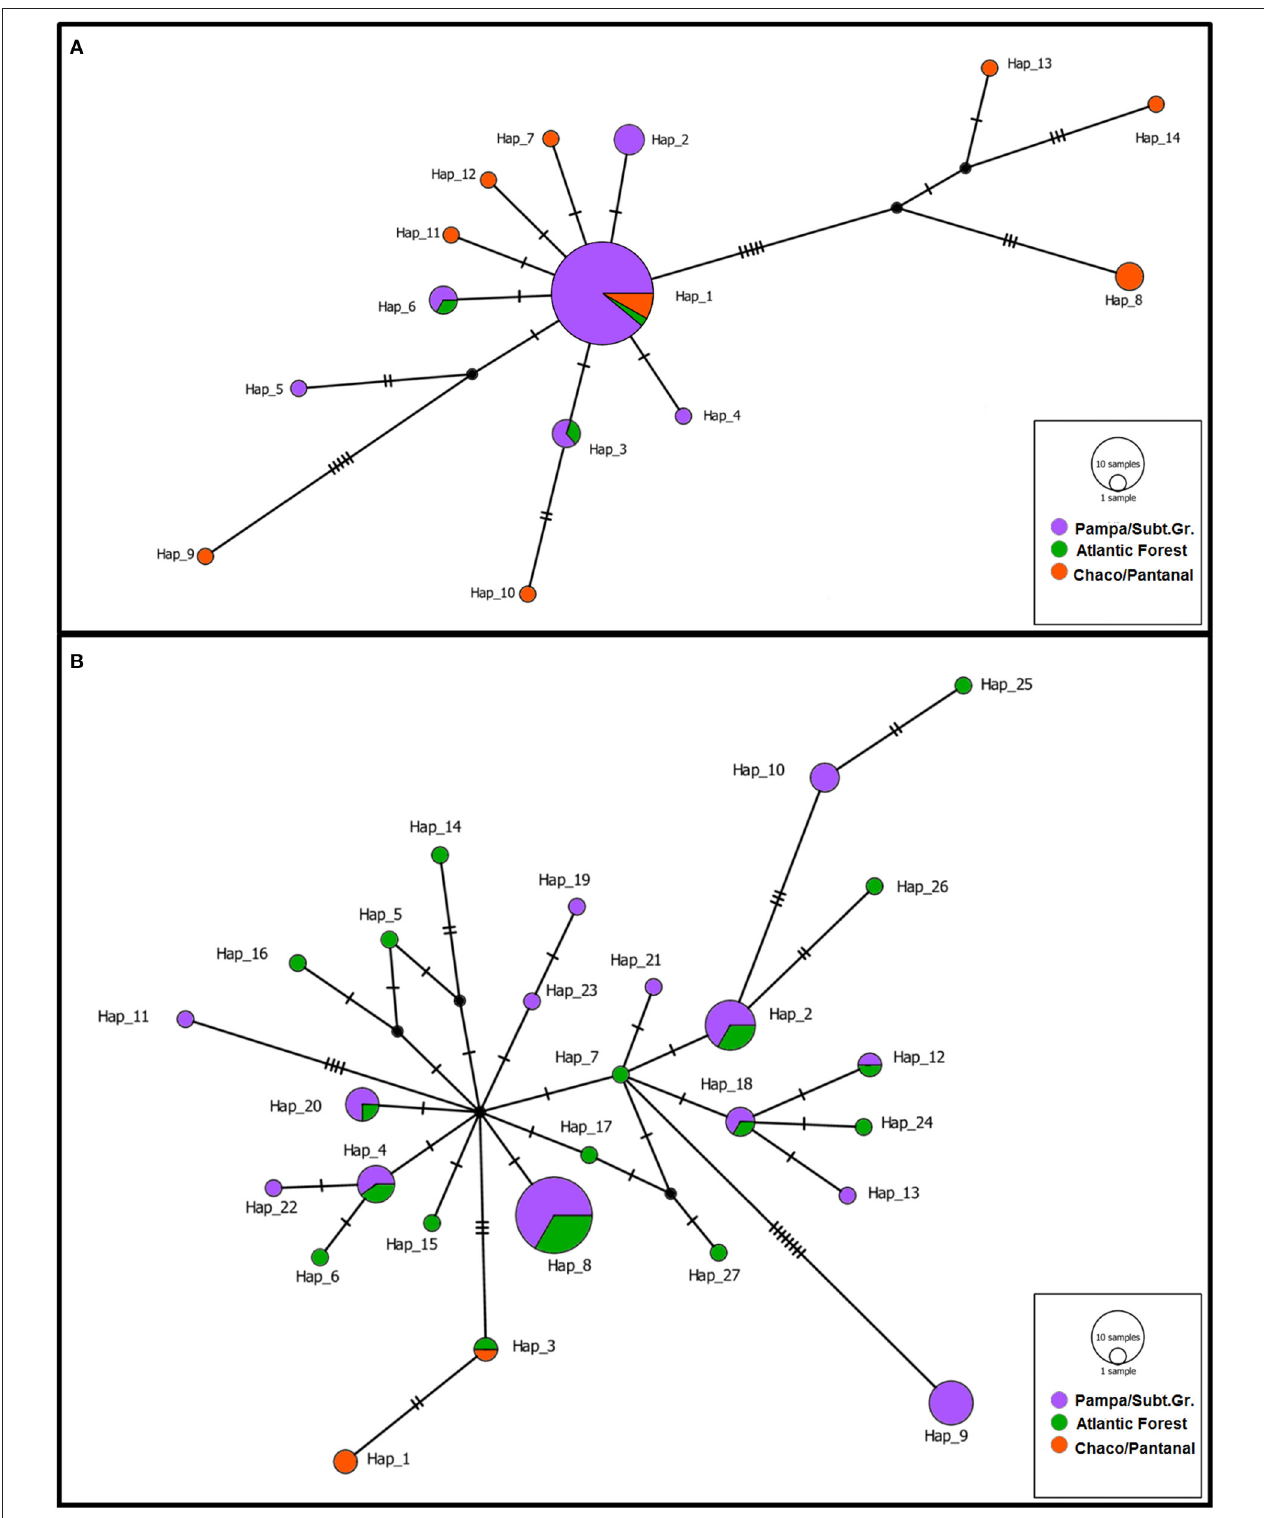
FIGURE 2 | Median-joining network for the haplotypes of red-crested cardinals (A) and green-winged saltators (B) . Circle size is proportional to the number of birds in the sample with that haplotype. Transversal lines represent mutational steps.